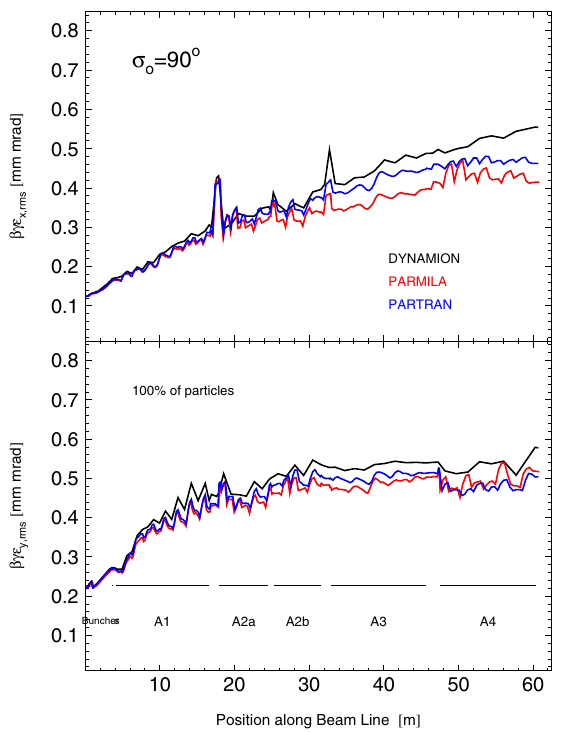
FIG. 16. (Color) Transverse normalized 100% rms emittances along the beam line as simulated by the three codes for a transverse zero current phase advance (cid:4) o of 90 (cid:1) . phase space distributions at the entrance to the DTL and comparing their rms-Twiss parameters with the periodic DTL solutions. Figure 20 depicts phase space distributions right in front of the DTL. The ellipses corresponding to beam rms-Twiss parameters and to the periodic solutions of the DTL are drawn as well. From the two sets of Twiss parameters, the resulting mismatch parameter M is calcu- lated using the definition given in [18]: